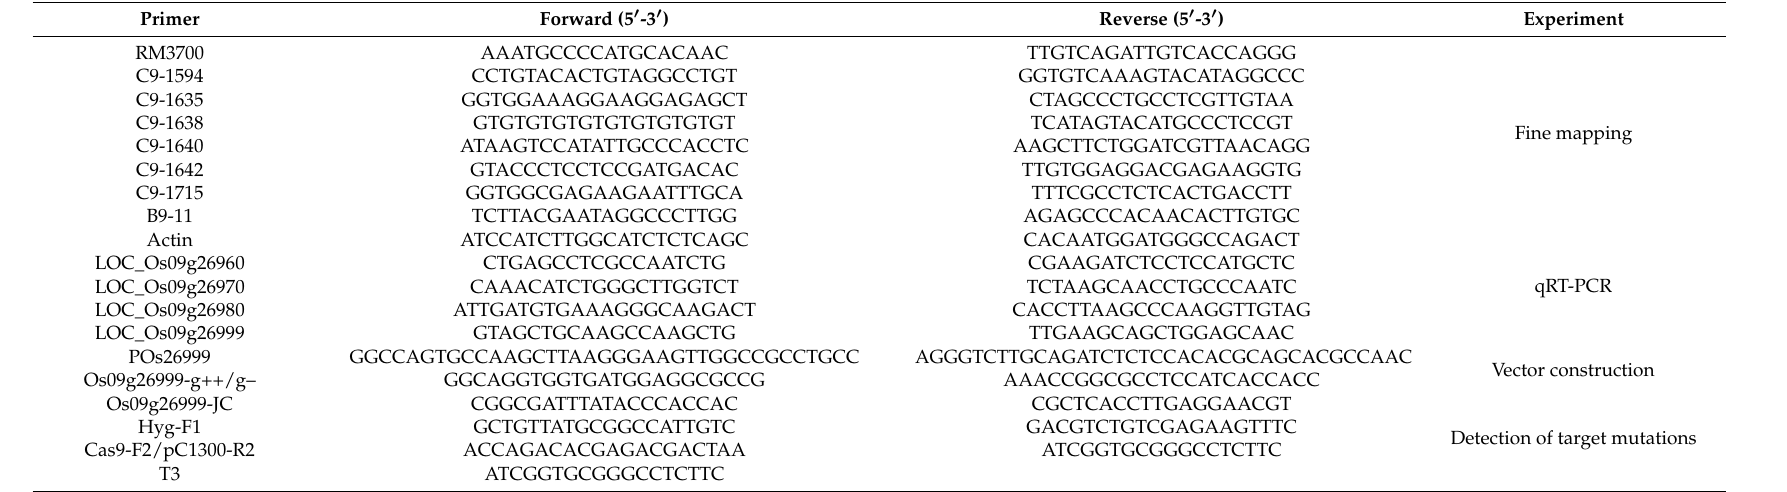
Table 3. Primers for QTL fine mapping, quantitative real-time polymerase chain reaction (qRT-PCR), vector construction, and gene